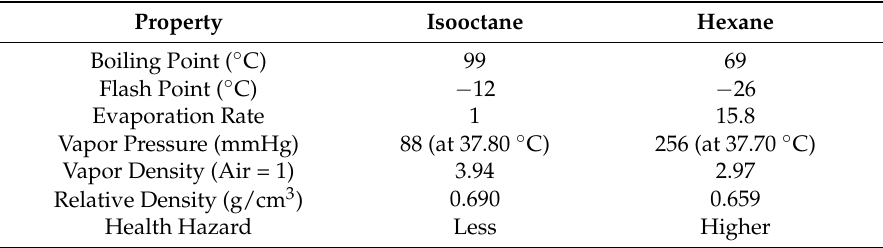
Table 1. A comparison of physical properties between isooctane and hexane. Property